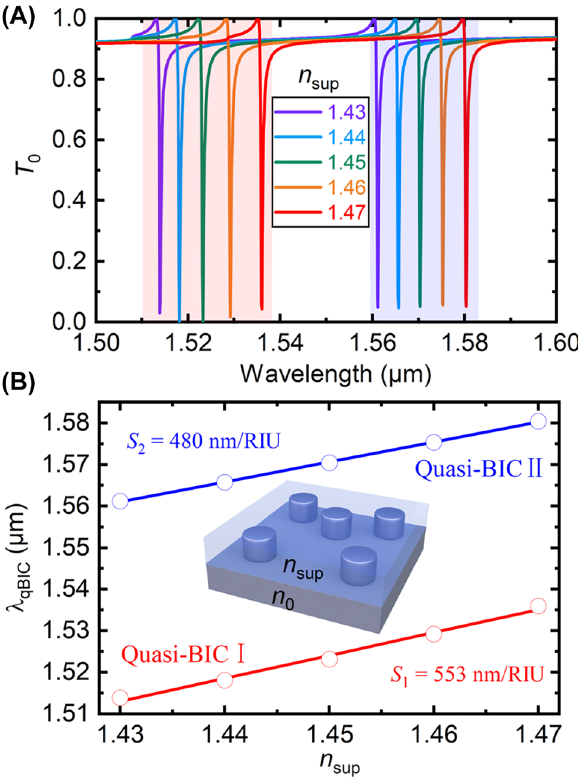
Figure 6: Refractive index sensing performance of the dual-band quasi-BICs. (A) Simulated zeroth-order transmittance spectra for different superstrate refractive indices. (B) Extracted resonance . Inset illustrates the refractive wavelengths as a function of n sup index sensing configuration based on the periodic silicon bipartite nanodisks with dual-band